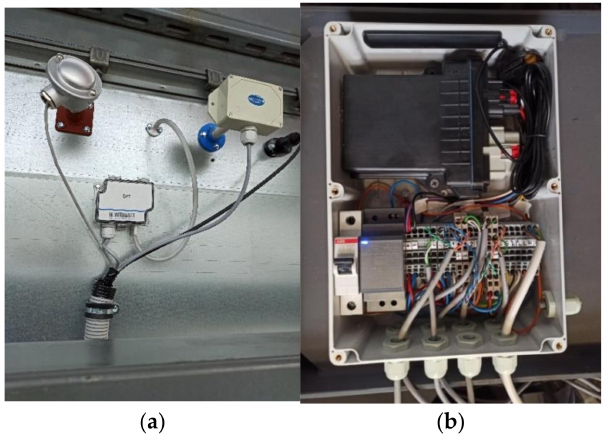
Figure 1. Several installed measuring sensors ( a ) and an electrical connection box with measuring signals and a modem for data transmission to the server ( b